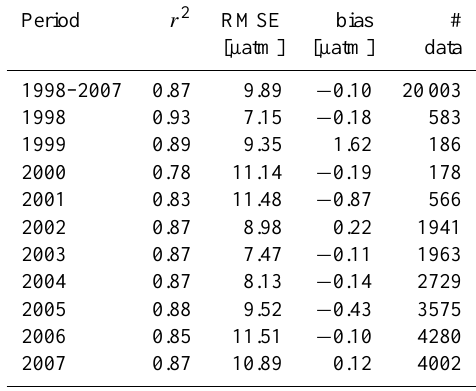
Table 2. Statistical measures of the comparison of the neural network-based estimates of p CO 2 with the SOCAT v1.5 gridded observations in the Atlantic Ocean from 44 ◦ S to 79 ◦ N and west